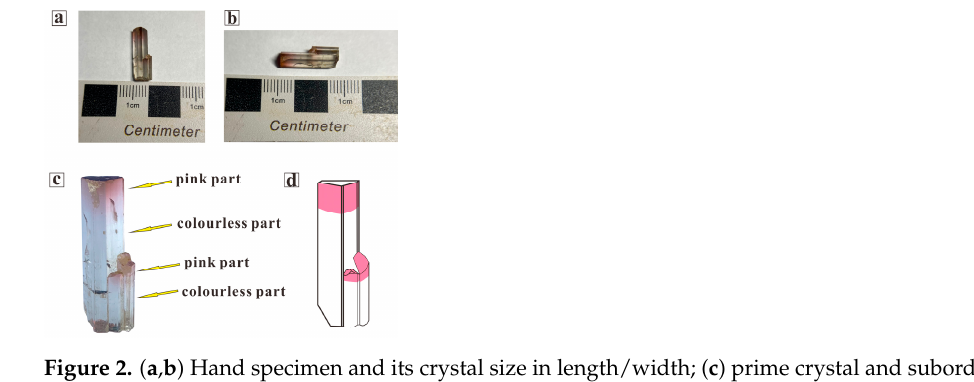
Figure 2. ( a , b ) Hand specimen and its crystal size in length/width; ( c ) prime crystal and subordinate crystal in this study show transparent appearance, euhedral gradual zonation from colourless to pink; ( d ) a simplified morphology sketch map of this hand specimen.